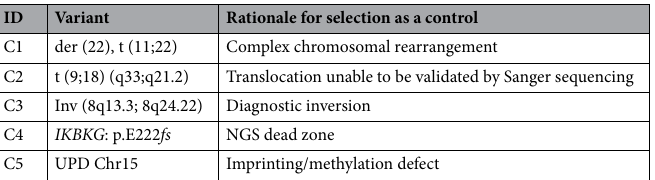
Table 1. Five controls with previously reported diagnoses.